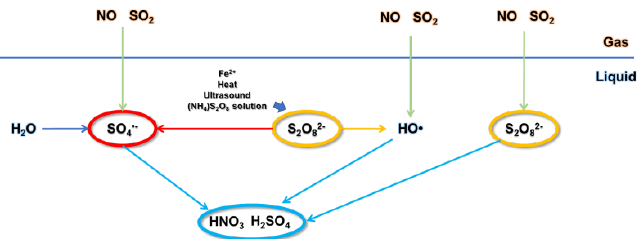
Figure 6. Removal mechanism of NO and SO 2 by ultrasound/Fe 2+ /heat/(NH 4 ) 2 S 2 O 8 system. Adapted from [79] .